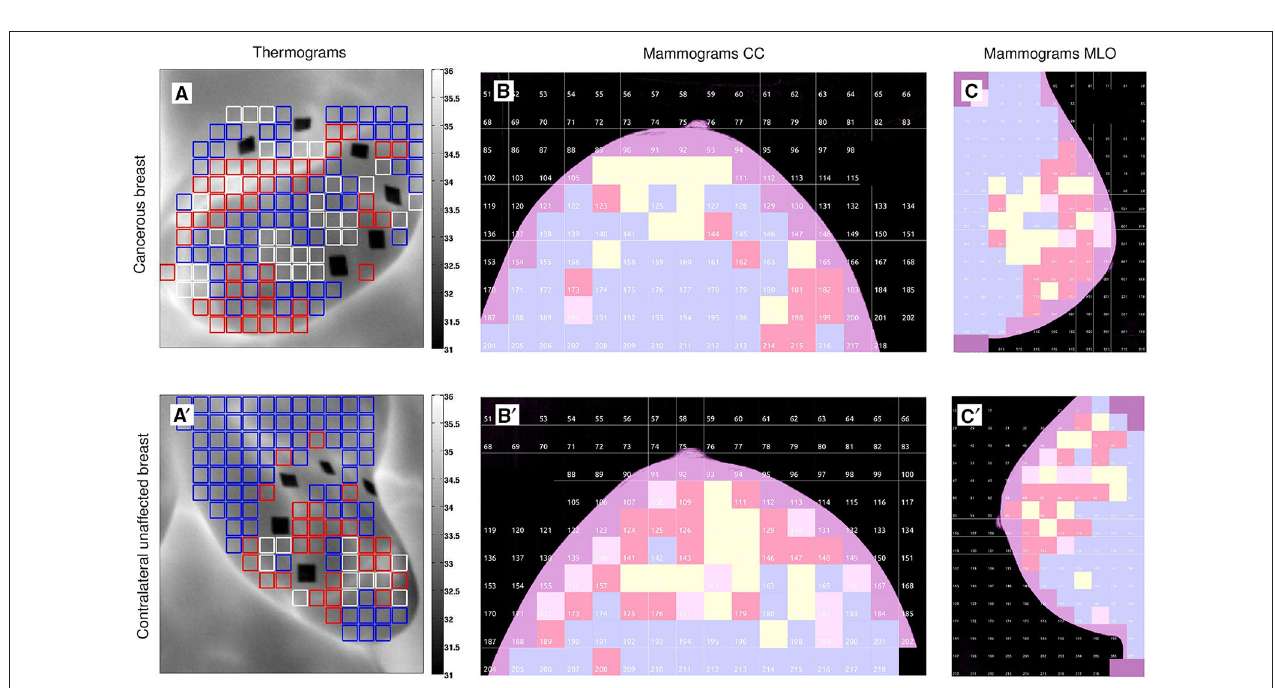
FIGURE 5 | Wavelet-based multifractal segmentation of dynamic infrared thermograms and X-ray mammograms. Same as Figure 1 but for patient 7 (age 47): cancerous right breast (A–C) and contralateral unaffected left breast (A ′ –C ′ ) .